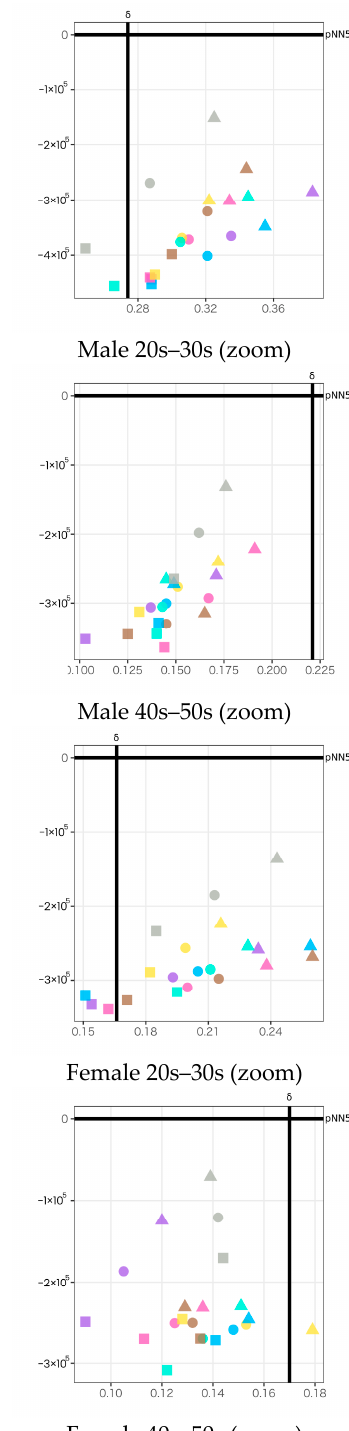
Figure 12. Emotion maps using pNN50 and MA H β /H α divided by gender and generation. The left fi gures show the full-scale emotion maps. The right fi gures show the zoomed version of the emotion maps on the left for a closer observation of the plots. The dots with di ff erent colors indicate the di ff erent olfactory stimuli as shown in the legend (Figure 10).